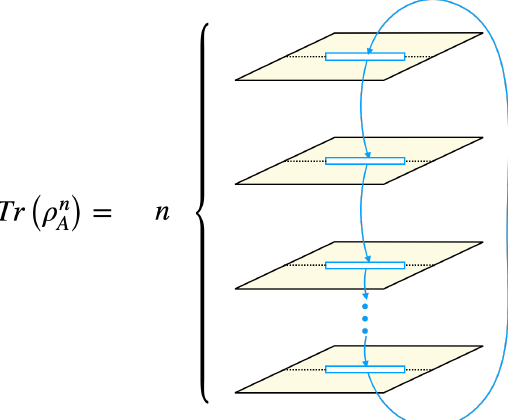
Figure 1: To compute the moments of the reduced density matrix, we prepare n copies of the state using a Lorentzian path integral. The copies are glued cyclically along region A (represented by the blue rectangles), implementing the matrix multi- plication, but sewn to themselves in region ¯ A , implementing the partial